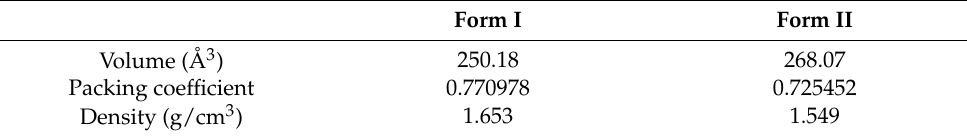
Figure 9. Packing in ( a ) form I and ( b ) form II, with a central molecule (pink) each having the same back-bone orientation. Hanging contacts were removed for better visualization. back-bone orientation. Hanging contacts were removed for better visualization. Table 1. Numerical Hirshfeld surface packing data for forms I and II. Table 1. Numerical Hirshfeld surface packing data for forms I and